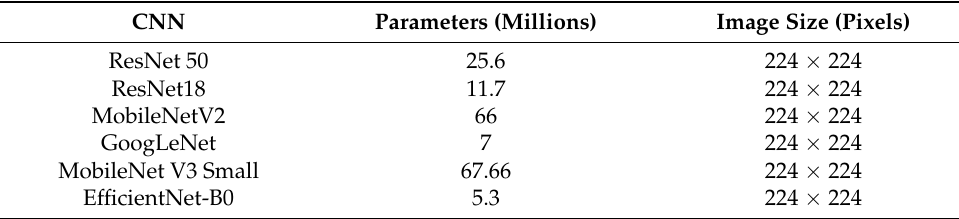
Table 3. Main characteristics of pre-trained models.